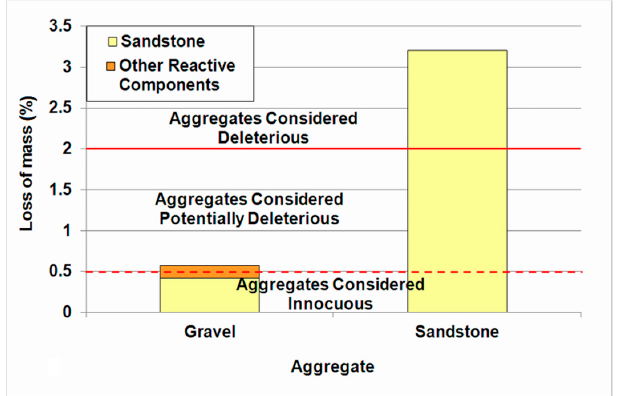
Figure 5. Loss of mass for particular aggregate fractions in NaOH solution.